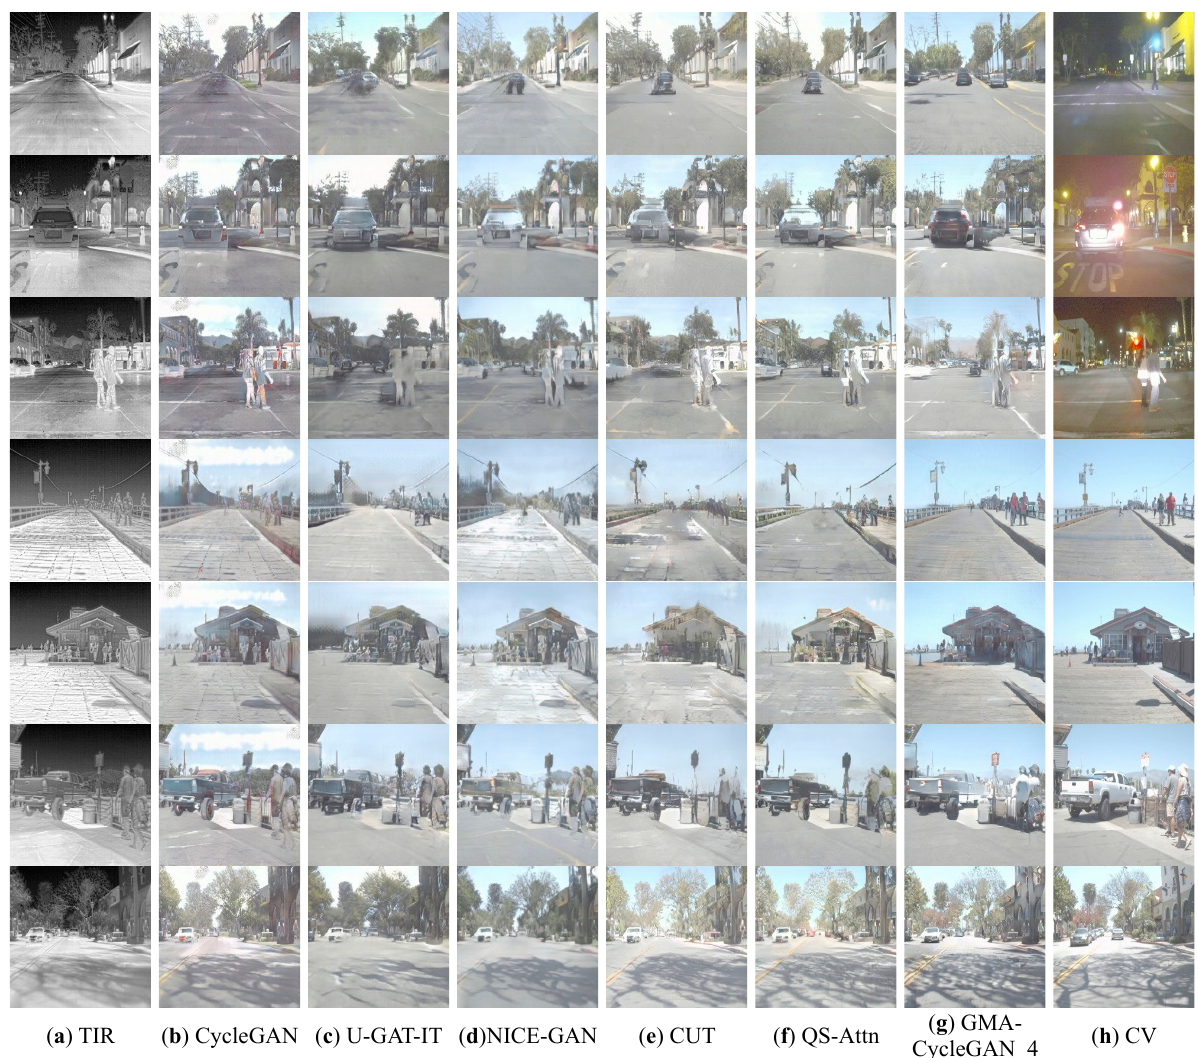
Figure 5. Translation results of different models.